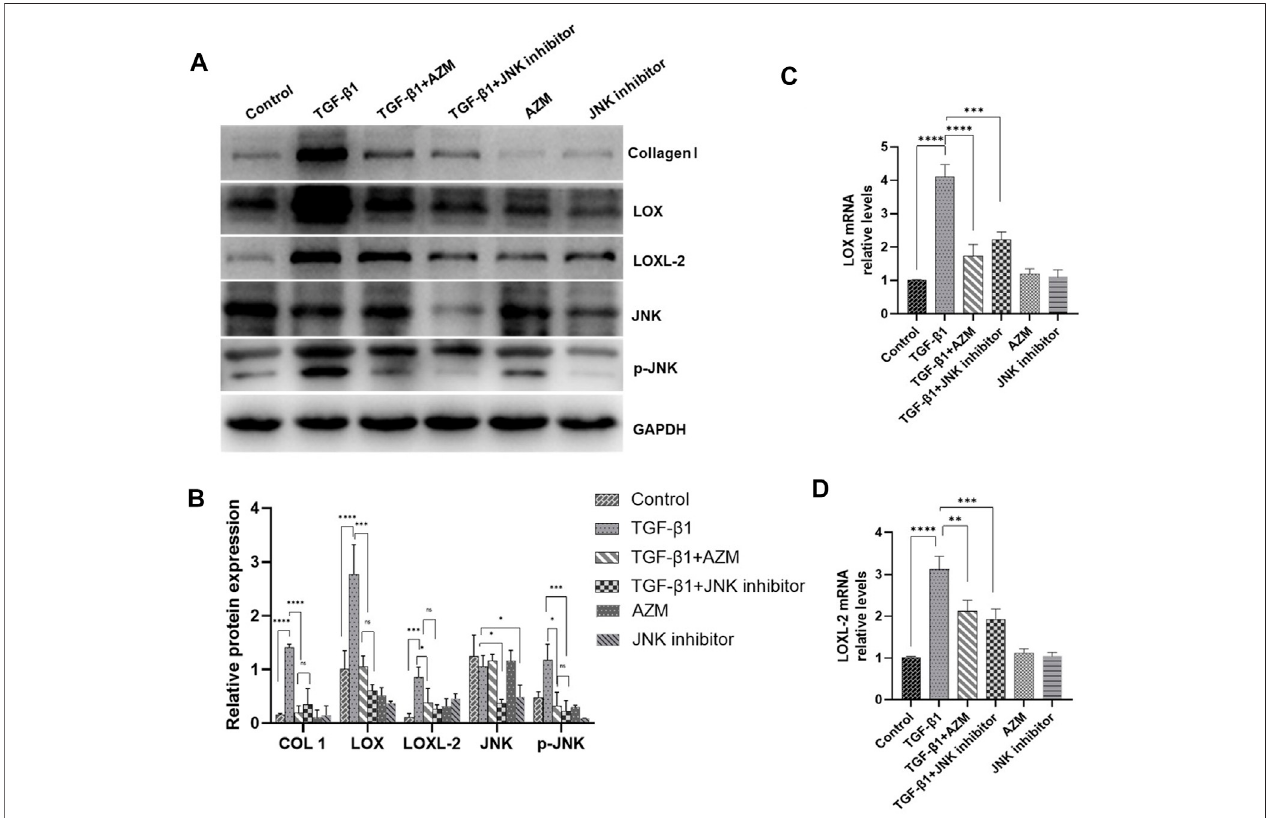
FIGURE 6 | AZM and JNK1 inhibitor (SP600125) have similar effects, and reduced the expression of LOX and LOXL2 in mice primary lung fi broblasts induced by 5 μ g/mlTGF- β 1. (A,B) TheproteinexpressionofLOX,LOXL2,COL1,JNKandGAPDHwasmeasuredineachgroupbyWesternblot. (C,D) ThegeneexpressionofLOX and LOXL2 was measured in each group by RT-PCR. Data were presented as the means ± SD ( n ≥ 3). * p < 0.05, ** p < 0.01, *** p < 0.001, **** p < 0.0001, ns, non- signi fi cant.